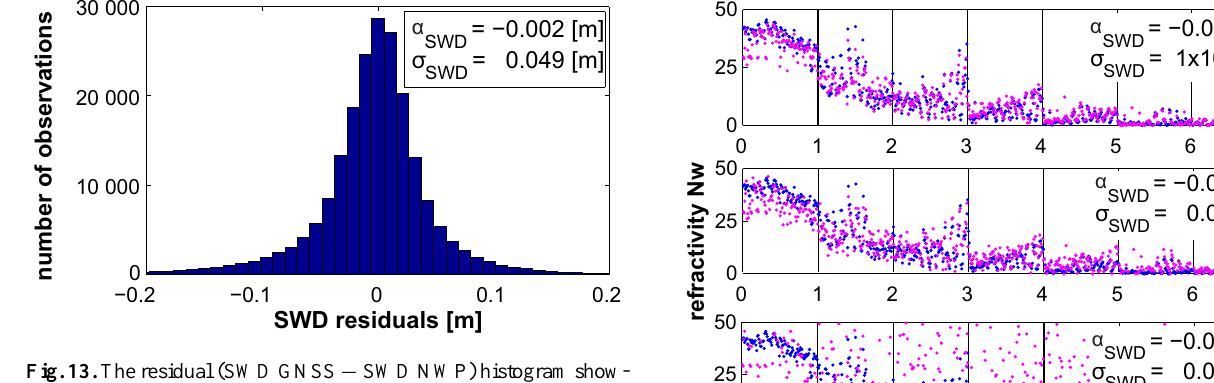
Fig. 13. The residual (SWD GNSS − SWD NWP) histogram show- ing comparison of the SWD from 24h of observations with re- spective SWD from raytracing through the NWP model, roughly 700000 scanning rays considered. Table 4. The error settings ( µ SWD – bias, σ SWD – standard devi- ation) for noise analysis (second and third column), with the noise responses from the model ( µ Nw – bias, σ Nw – standard deviation) in the fourth and fifth column. Last column shows condition number k of design matrix.